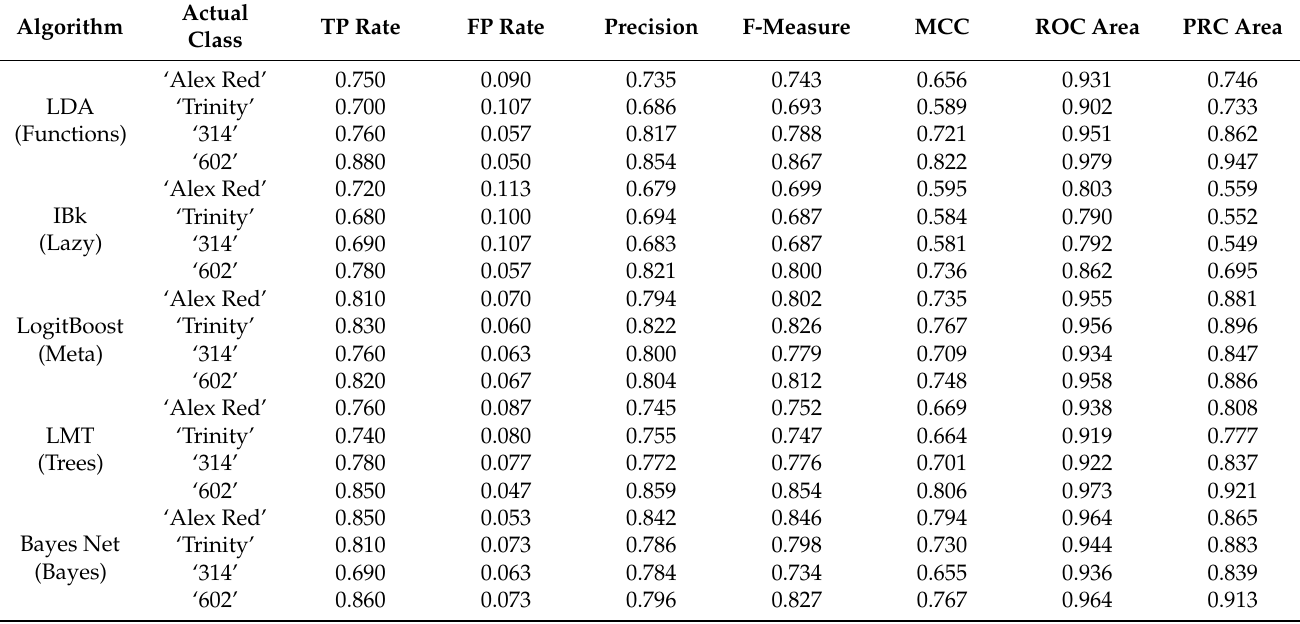
Table 9. The performance metrics of the classification of freeze-dried red-fleshed apple cubes based on selected image textures and color